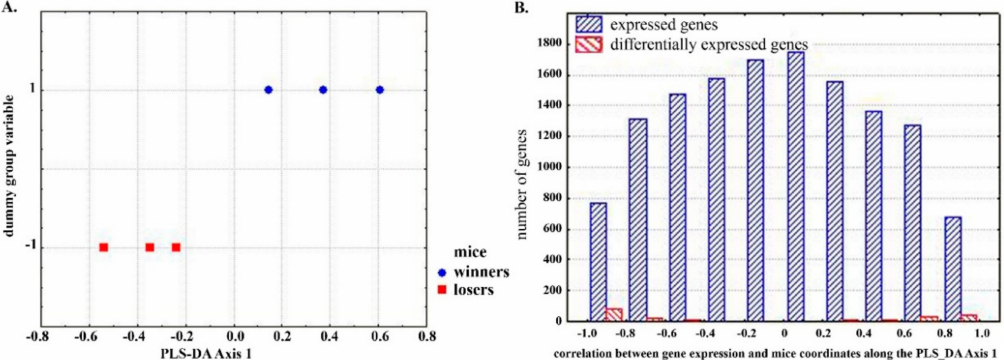
Figure 1. ( A ). Axis maximizing the distances between winning and defeated mice; ( B ). The distribution of expressed genes along the axis representing the correlation between gene expression and mice coordinates along the partial-least squares discriminant analysis (PLS-DA) Axis